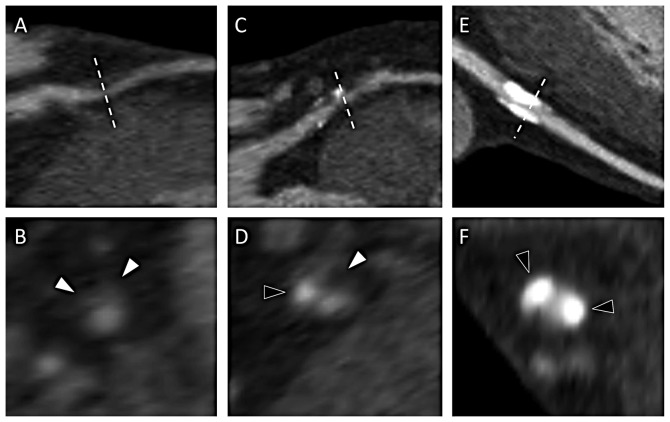
Different plaque compositions as seen by CCTA.The different types of coronary plaque are shown in longitudinal views, with cross-sectional views at the level of the dotted line. A non-calcified plaque is shown on the left (A and B), with white arrowheads pointing at the non-calcified plaque component. A mixed plaque is shown in the middle (C and D), with a white arrowhead indicating the non-calcified plaque component and a black arrowhead indicating the calcified component. A large calcified plaque is shown on the right side (E and F), with black arrowhead indicating the calcifications.